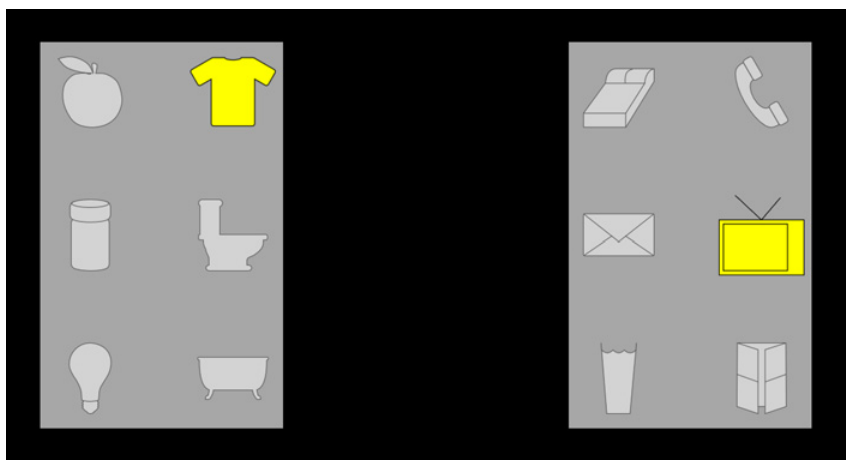
Fig 2. Example of stimulus for the third experiment. Icons from left and right parts of the screen are simultaneously flashed one at a time in random order while the background rectangles are flickering at 12Hz (left) and 15Hz